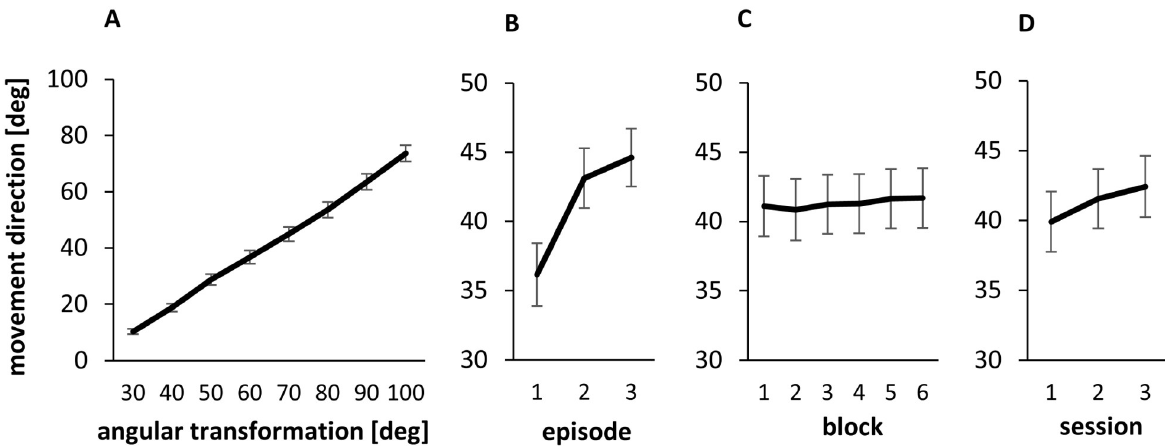
Fig 4. Mean performance averaged across the four adaptation tasks. 0˚ represents the unadapted expectation. A: The size of the angular transformation corresponds to the expected value for complete adaptation. B-D: 65˚ represents the expected value for complete adaptation. B-D show the mean adaptation progress in different timescales (B: episodes, C: blocks, D: sessions) averaged across all angular transformations. Illustrated are between-subject means and standard errors.